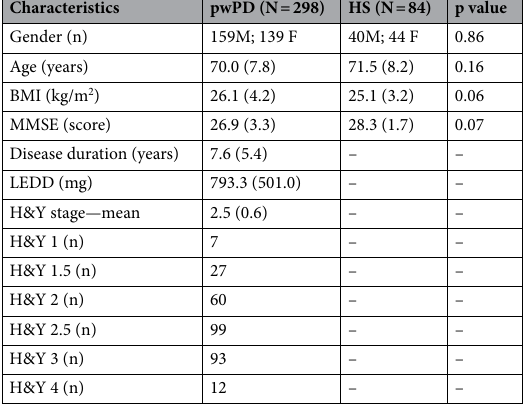
Table 1. Clinical characteristics of patients with Parkinson’s Disease (pwPD) and healthy subjects (HS). BMI, body mass index; MMSE, mini-mental state examination; LEDD, levodopa equivalent daily dosage; H&Y, modified Hoehn and Yahr